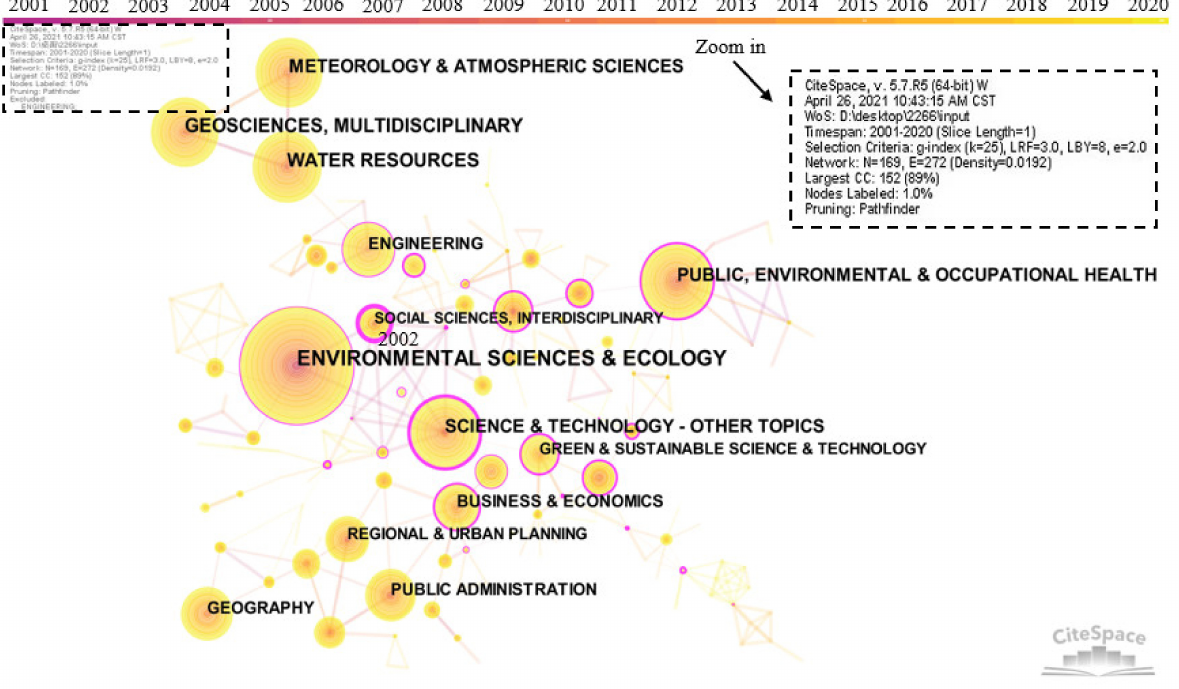
Figure 6. Network visualization map of categories in community resilience research from 2001 to 2020. Note that the size of circle refers to the number of articles. The thickness of the outer pink circle represents the size of